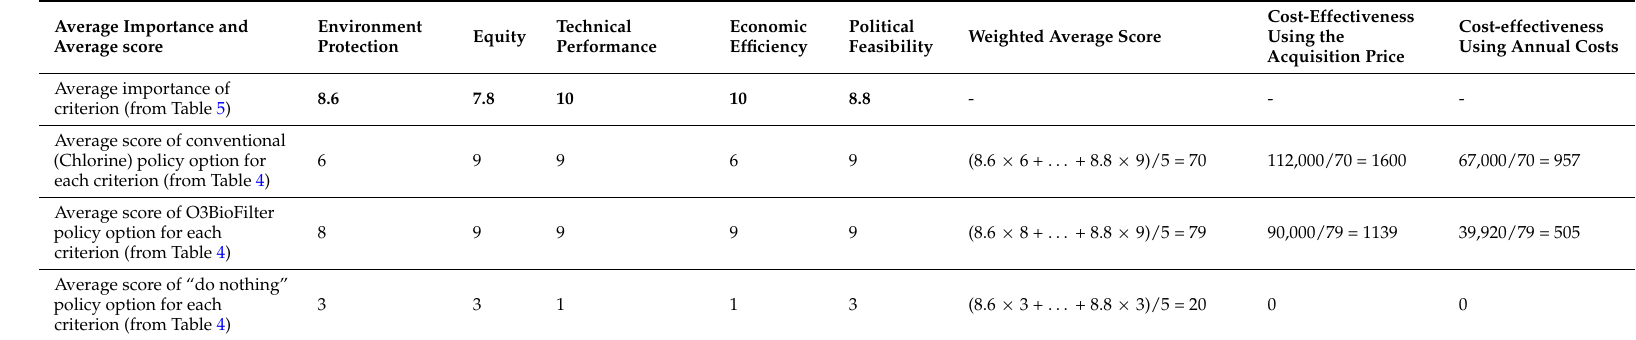
Table 6. Weighted average scores and cost-effectiveness of policy options.